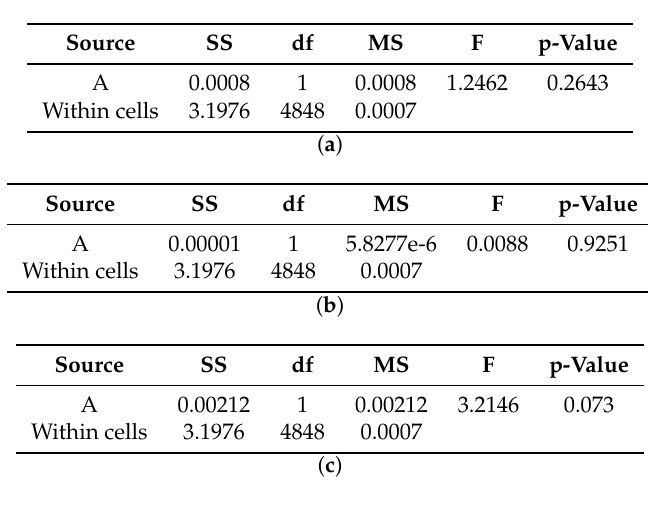
Figure A5. ANOVA tables for the analysis of the effect of factor A (initial distance of the object to the sensor) on the expected accuracy of the filter. ( a ) One-way ANOVA for factor A given C = 1. ( b ) One-way ANOVA for factor A given B = 1 and C = 2. ( c ) One-way ANOVA for factor A given B = 2 and C =